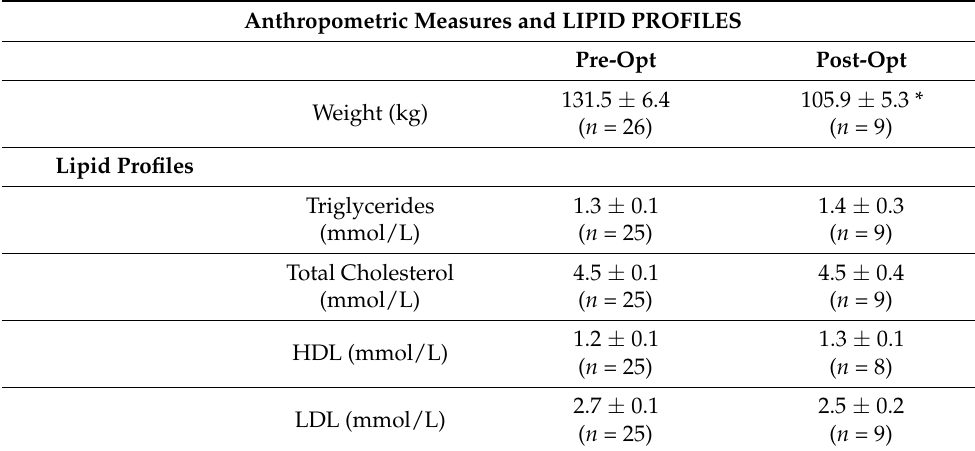
Table 2. Anthropometric measures and lipid profiles of participants at pre- and post- bariatric